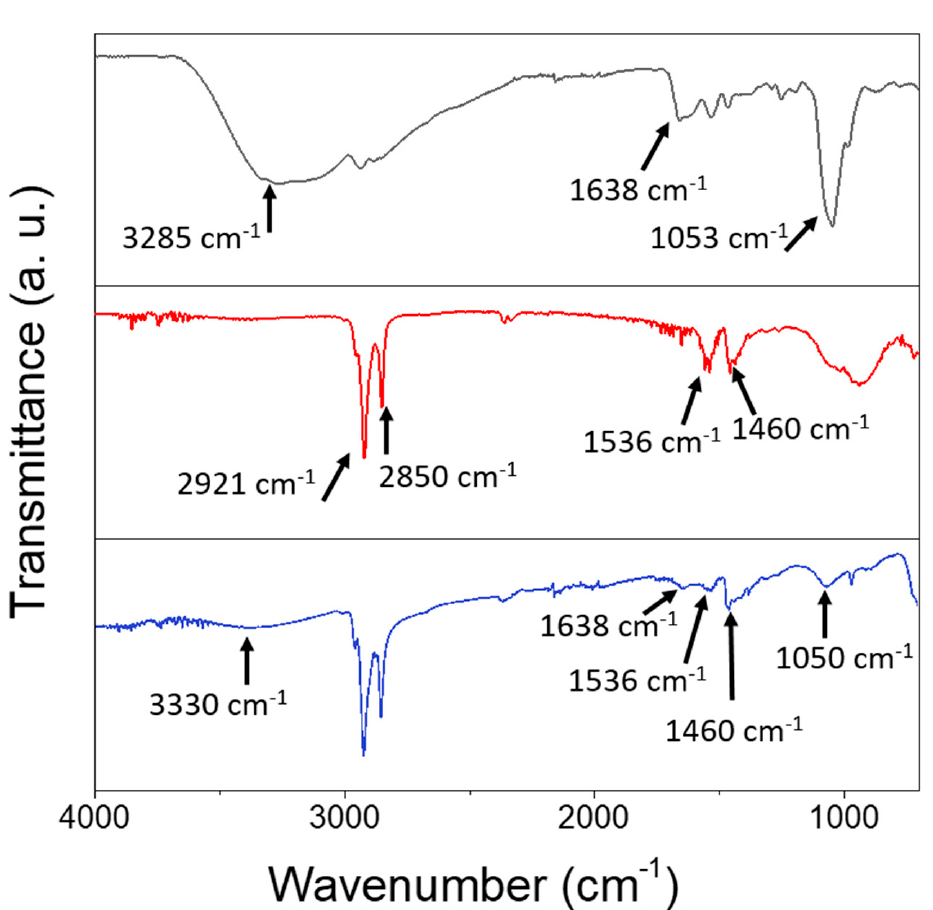
Figure 4. FTIR-ATR spectra of PDA (black line), SPIONs (red line) and SPION@PDA nanoparticles (blue line), cast from aqueous solution.